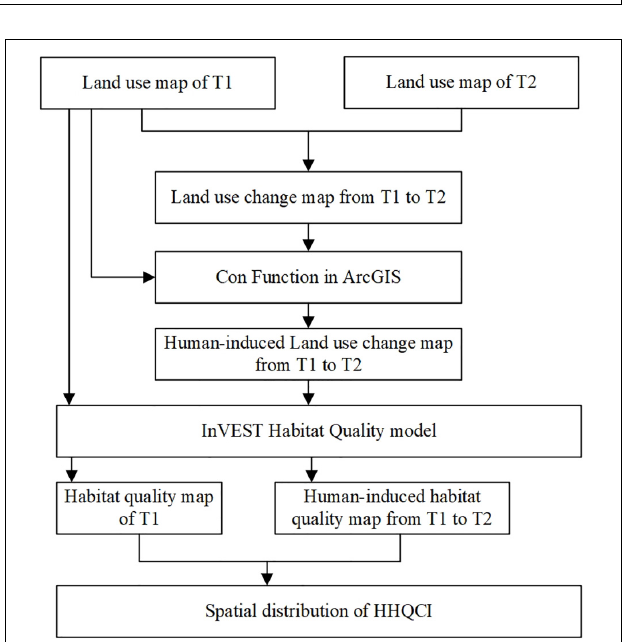
FIGURE 2 | Definition of human-induced land-use changes.